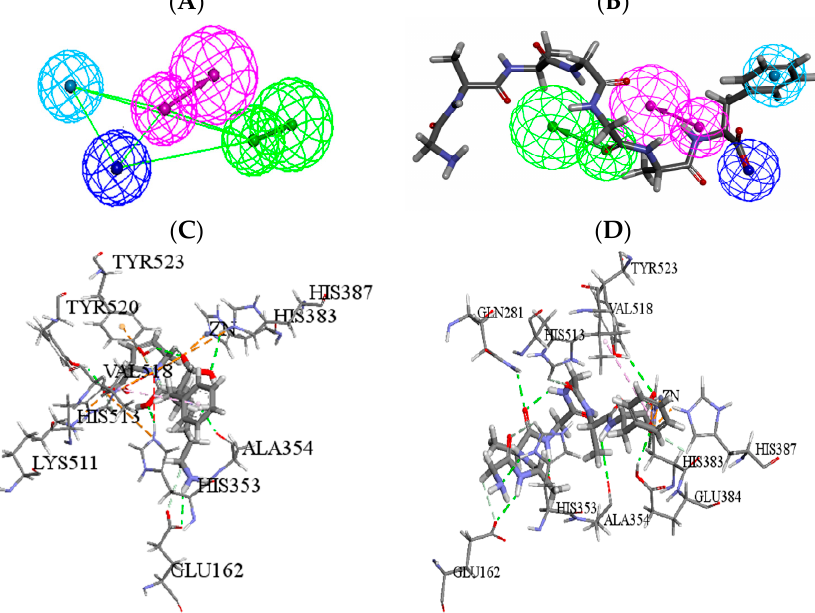
Figure 3. Representation of the angiotensin converting enzyme (ACE) pharmacophore model. Purple sphere indicated hydrogen bond donor, green sphere indicated hydrogen bond acceptor, light blue sphere indicated hydrophobic aromatic features, and dark blue sphere indicated negative ionizable. ( A ) Represented the best pharmacophore model of ACE; ( B ) represented the ACE pharmacophore model mapped with GAAGGAF. Molecular interactions between PDB 1O86 and the ligands; ( C ) Lisinopril; and ( D ) GAAGGAF.